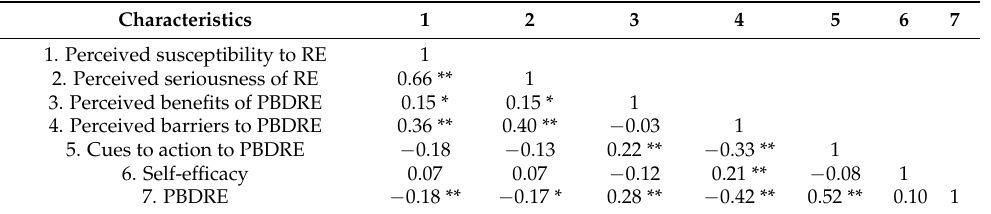
Table 3. Correlation of PBDRE-related factors based on